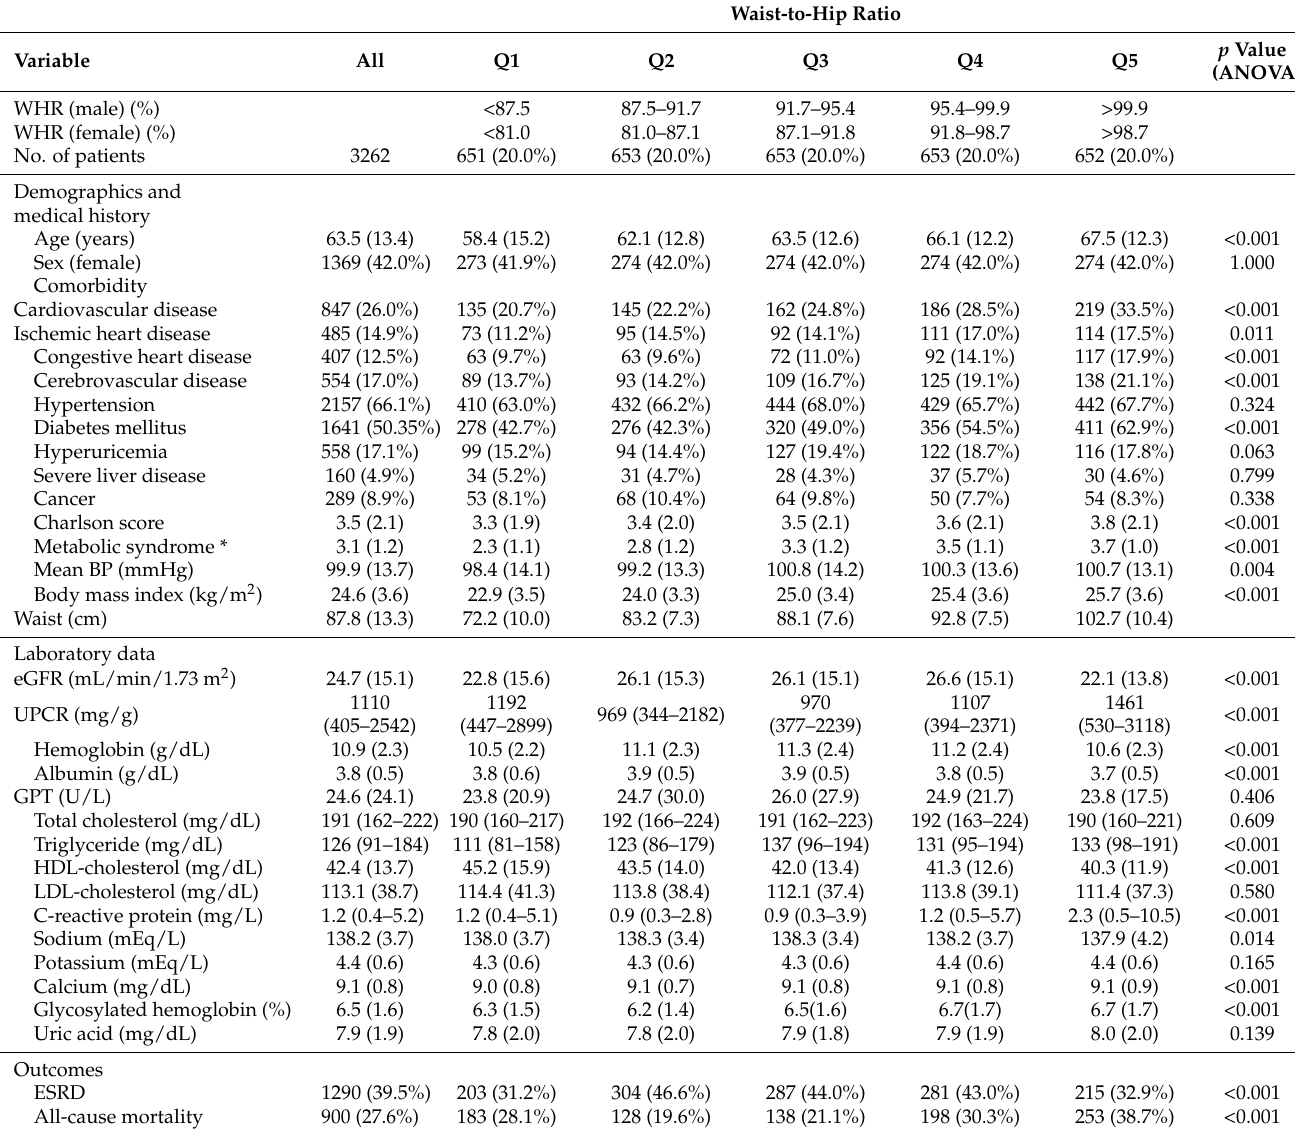
Table 1. Baseline characteristics of patients by WHR